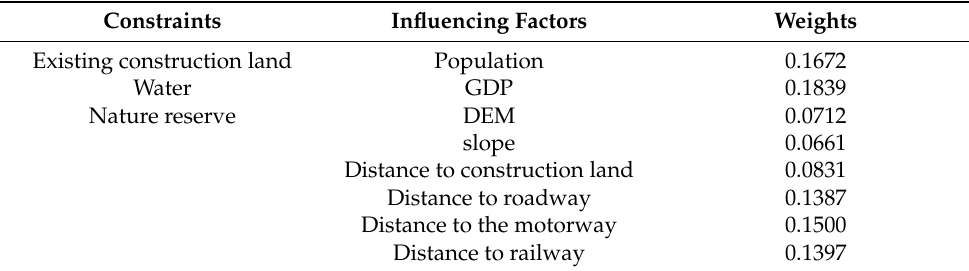
Table 1. Driving factors identified in the suitability analysis of construction